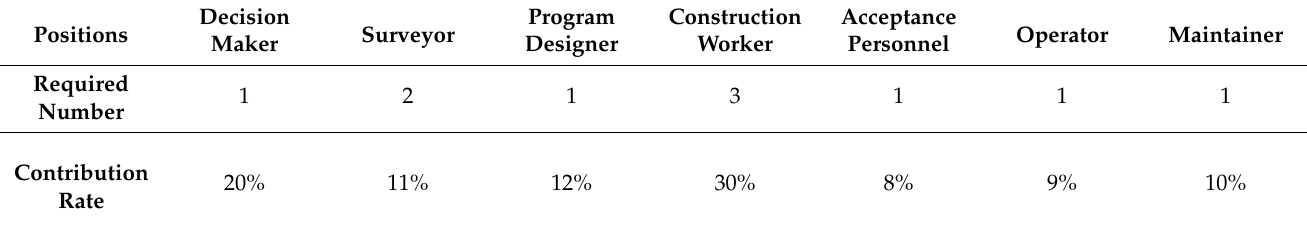
Table 2. Required positions and their